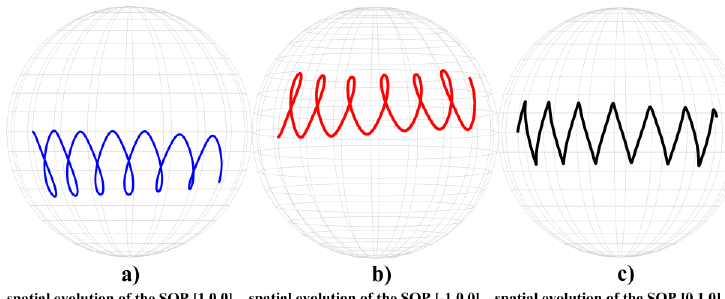
Figure 2. Spatial evolution of the SOPs in a twisted fiber.